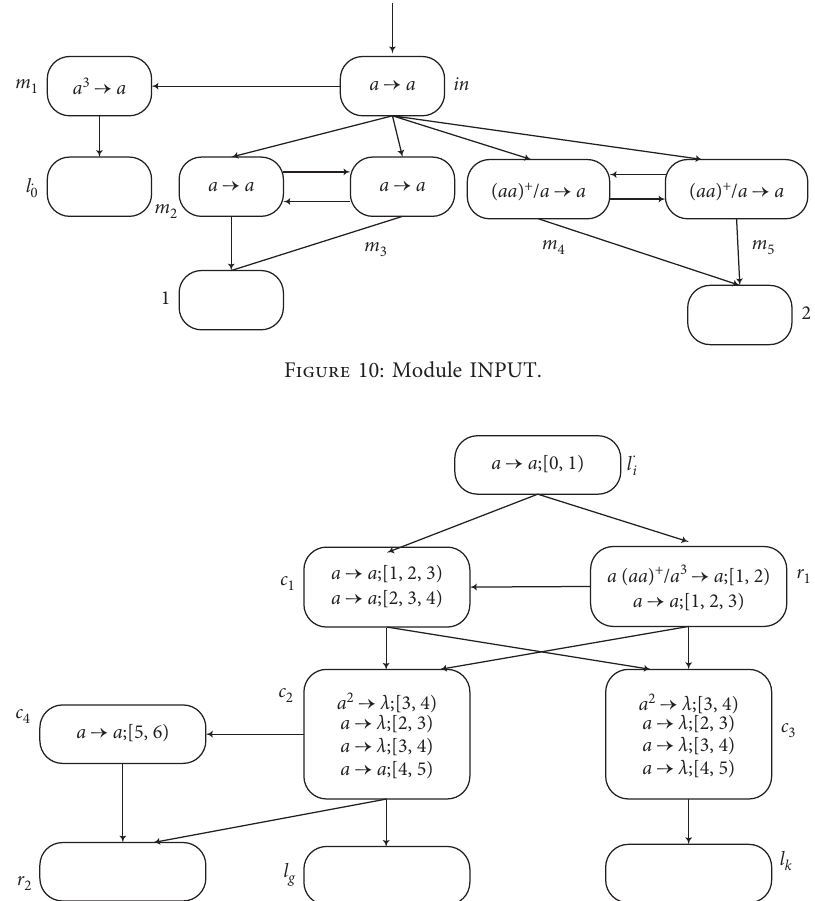
Figure 11: Module SUB-ADD-1: simulating the consecutive SUB instruction l